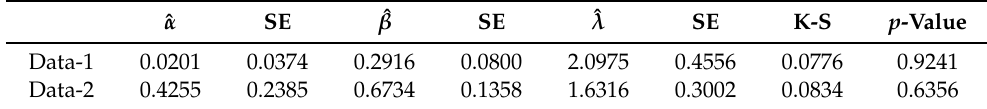
Table 4. Summary of fitted CBellW model for the data